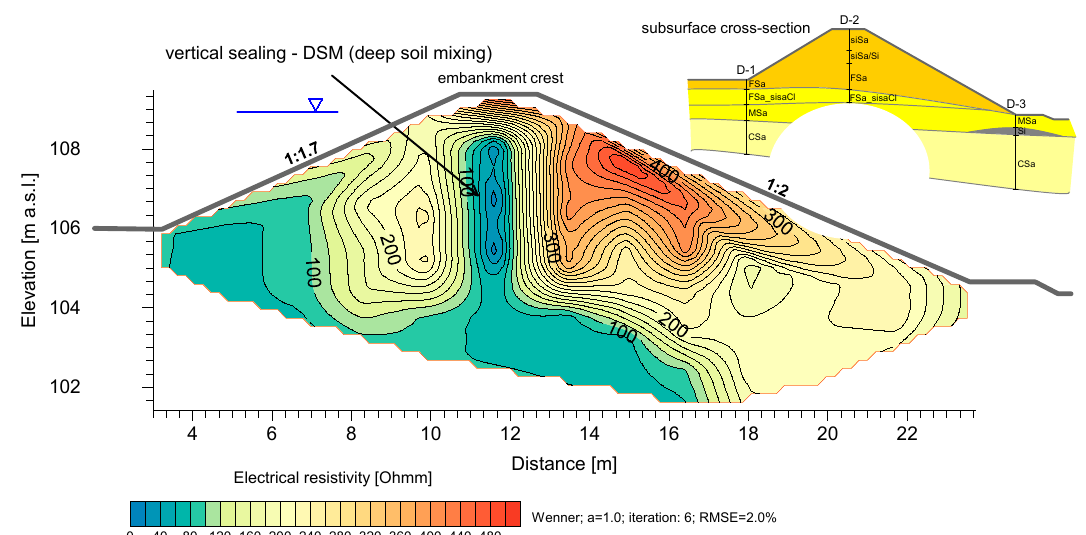
Figure 14. Geoelectrical cross-section across the embankment body after installing the sealing system.